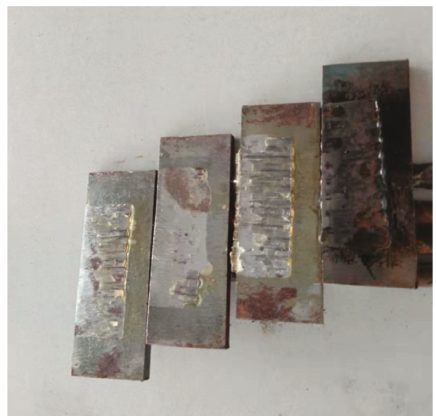
Figure 6: Typical failure diagram of a